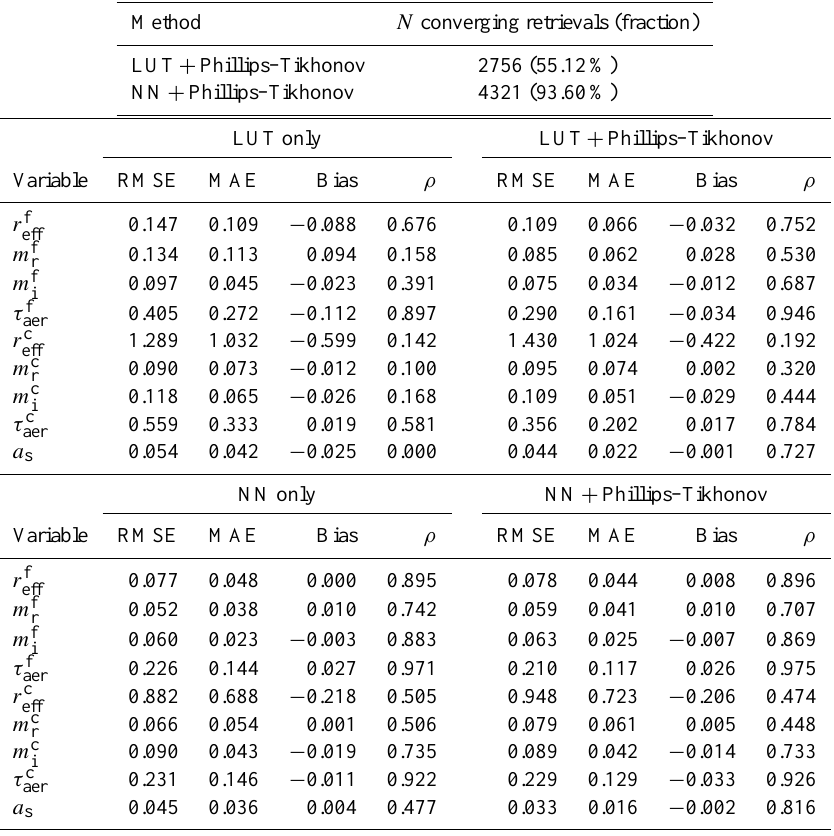
Table 5. Root-mean-square error (RMSE), mean absolute error (MAE), mean bias and Pearson correlation coefficient ( ρ ) between retrieved and actual aerosol parameters. Please refer to Table 2 for the meaning of the symbols in the first